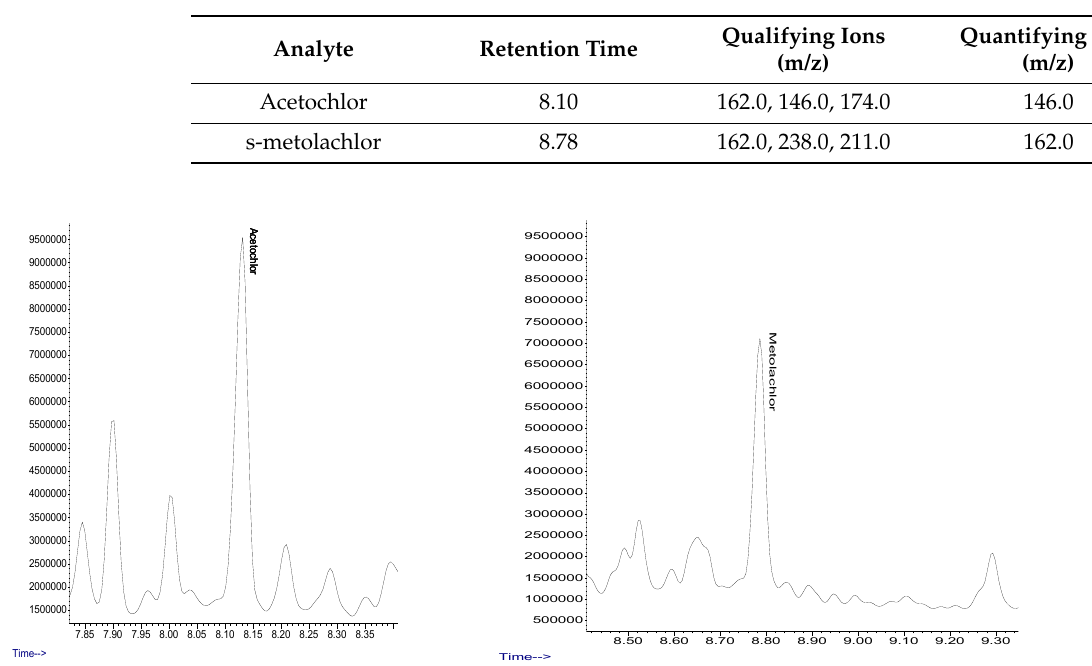
Figure 2. The GC-MS chromatograms of acetochlor and s-metolachlor in scan mode.